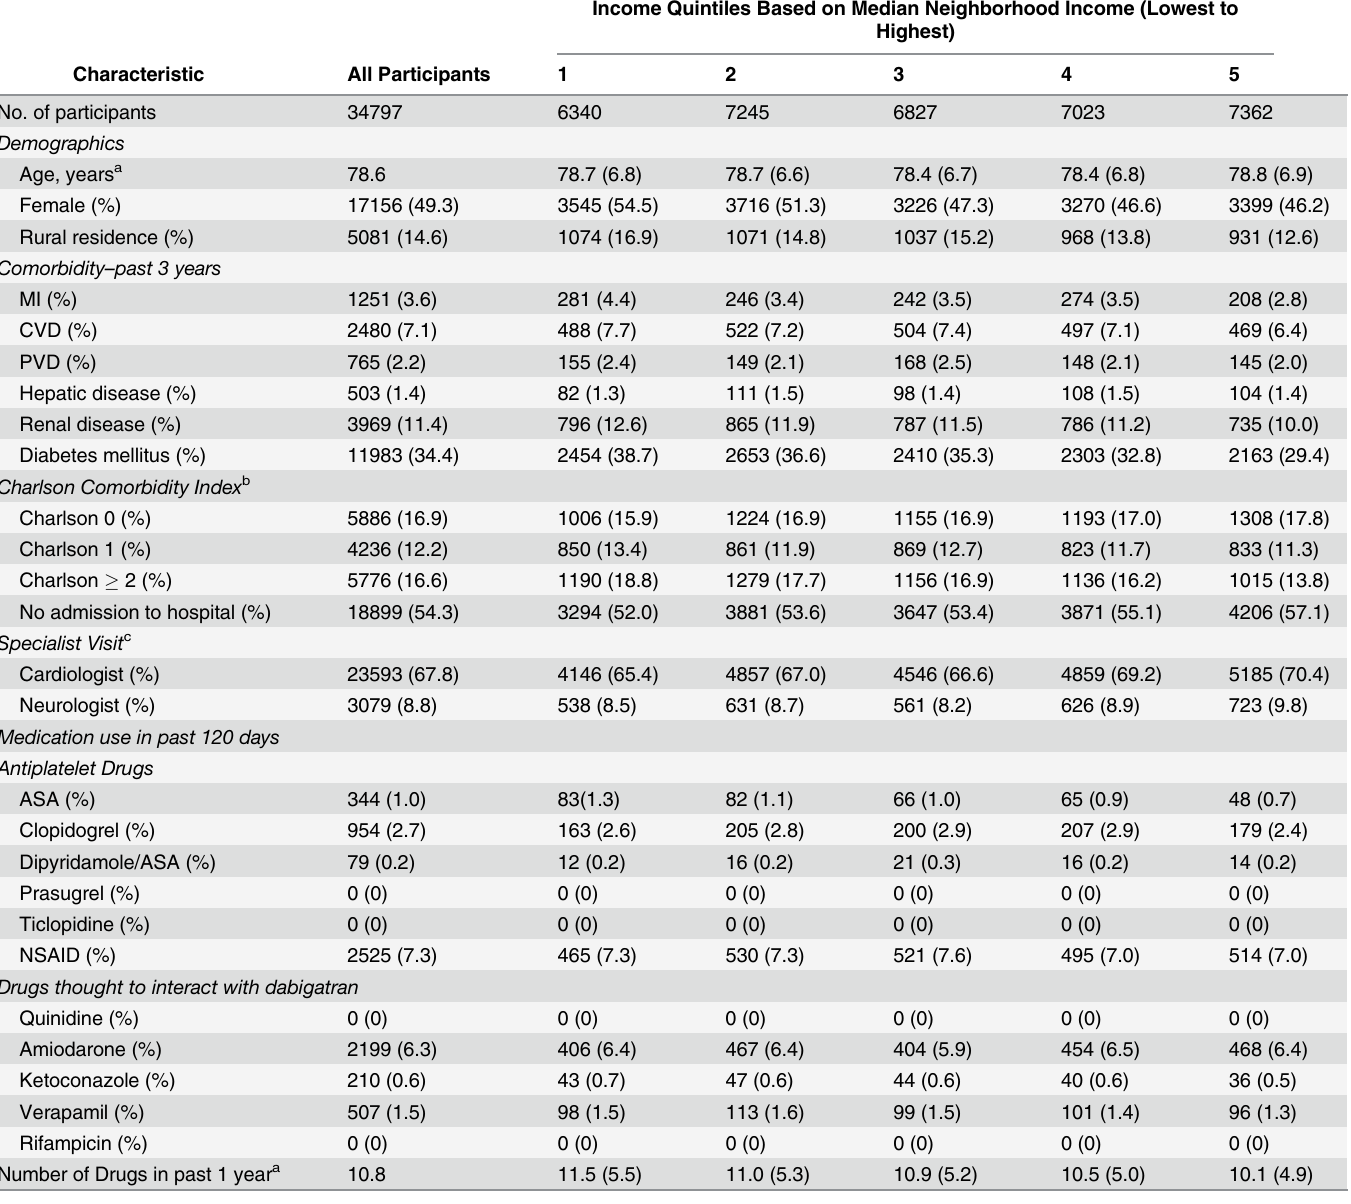
Income Quintiles Based on Median Neighborhood Income (Lowest to